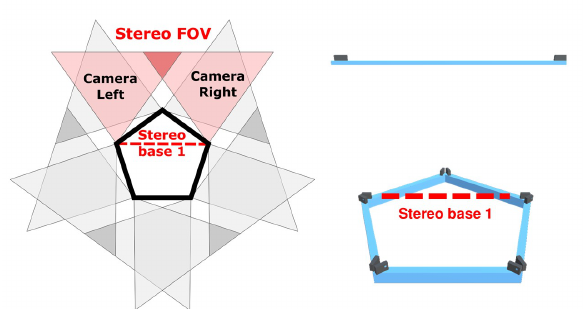
Figure 1. 360 degree camera rig: concept with horizontal field of view (bright red) and stereo field of view (dark red) (left), camera rig with horizontal and upwards facing stereo base (right) The stereo camera rig is formed by a horizontal polygon with five corners. On every corner, two cameras are positioned.